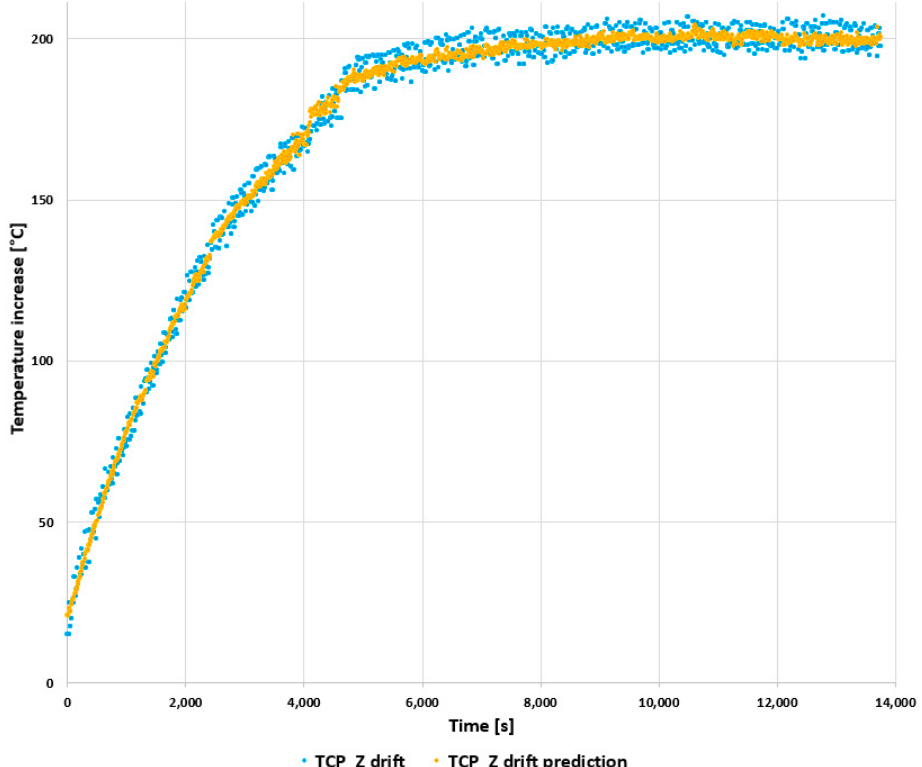
Figure 7. MatLab TCP Z Drift prediction, Target 1, maximal speed. Presented trends: blue points—measured robot drift, yellow points—drift prediction calculated by MatLab regression learner.